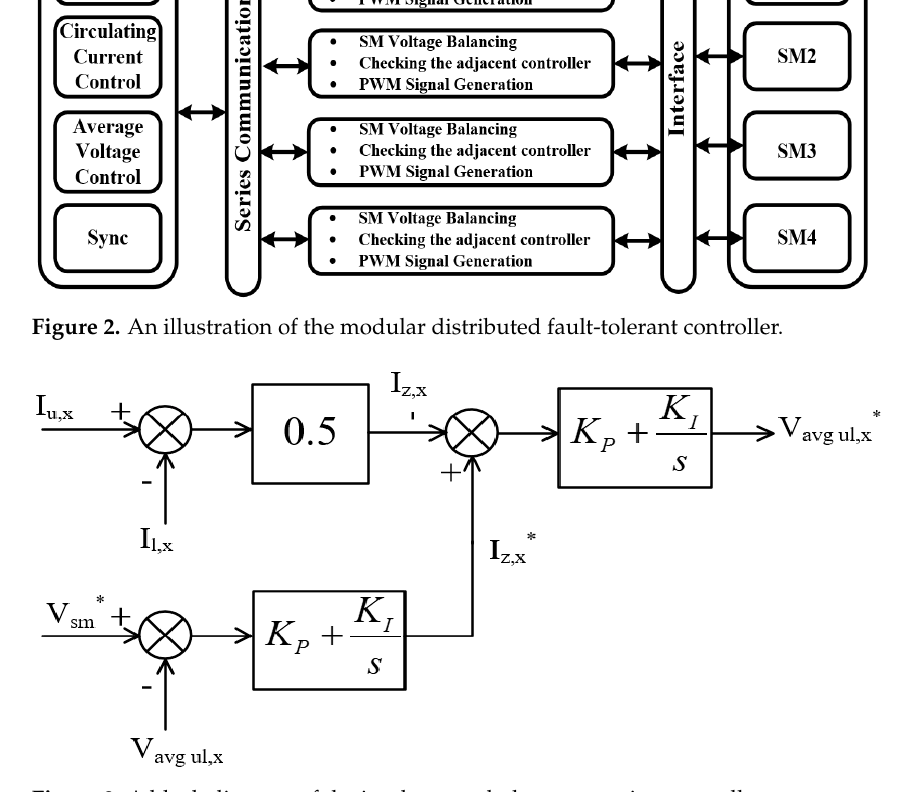
Figure 4. Modular distributed fault-tolerant controller.